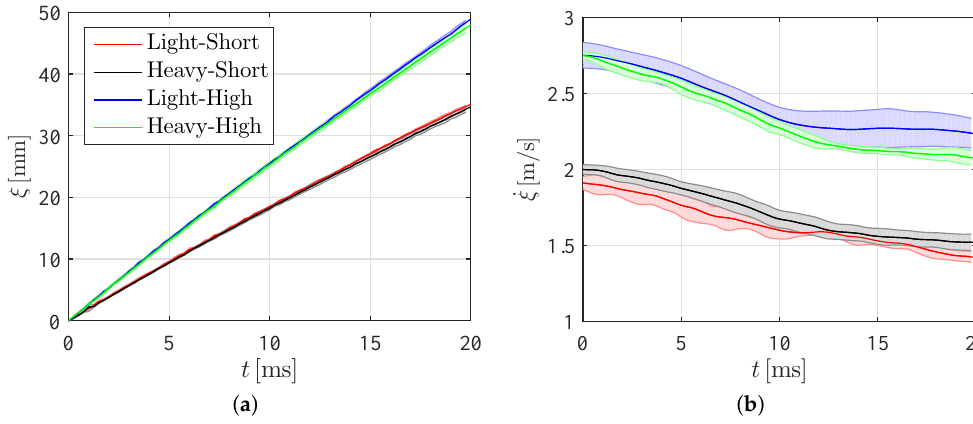
Figure 5. ( a ) Time trace of the mean entry depth and ( b ) mean velocity of the keel for different conditions. The shaded area represents one standard deviation across